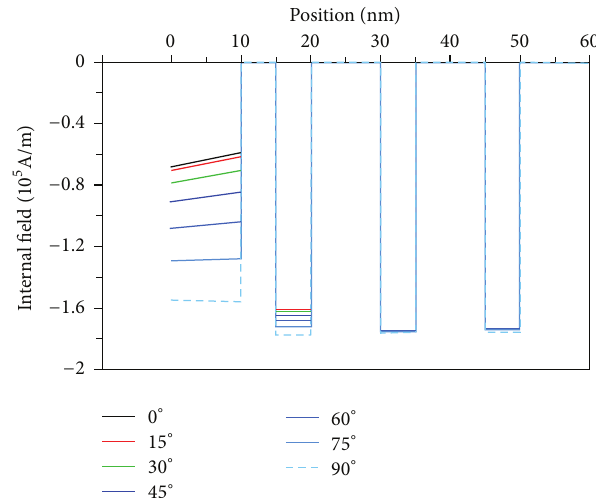
Figure 2: Spatial profiles of the internal effective field, for different directions of the applied field of constant magnitude 𝜇 0 𝐻 0 = 0.1 T (degrees, indicated in figure). Note that the internal field is zero in correspondence with the void spaces. At 0 ∘ the discrepancy between the region 0–10 nm and the other regions is the largest, while at 90 ∘ it is the